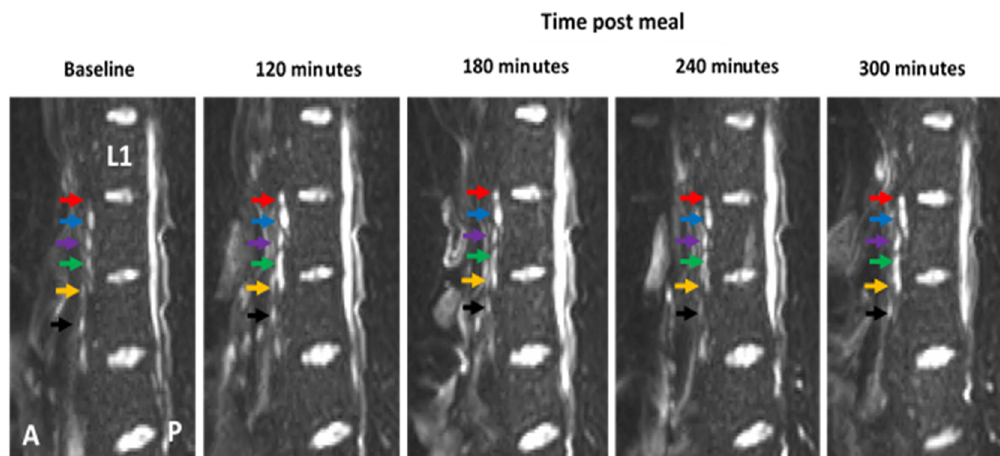
Figure 3. Example of diffusion weighted image (DWI) showing how the vertebra of the spine can be used as an anatomical marker to allow for the same lymph nodes to be consistently imaged at multiple time-points pre- and post-meal. The first lumbar vertebra is indicated (L1) and lymph nodes are indicated by coloured arrows. Colours represent the same individual lymph at each time point. The anterior side (A) of the body is to the left of each image and the posterior side (P) is on the right. Table 1. Vertebral level of nodes imaged across all time points. Data represent the mean across all participants ± SEM.